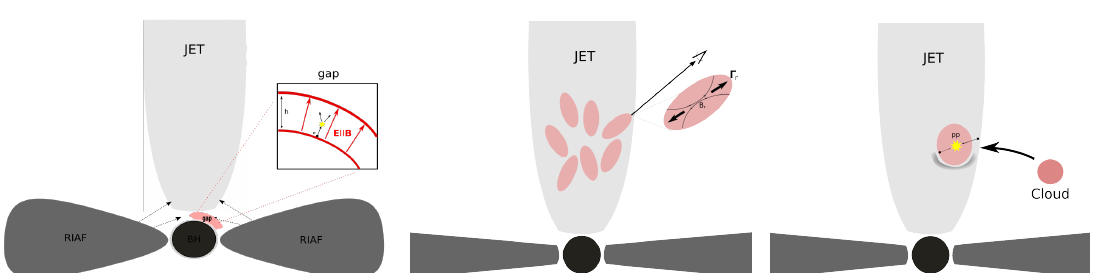
Figure 3. Possible scenarios for the origin of rapidly-variable VHE emission in AGN. Left: Particle acceleration in unscreened (“gap”) electric fields close to the black hole horizon triggers an electron-positron pair cascade, which is accompanied by inverse Compton up-scattering of the ambient disk photon to the VHE regime. VHE variability then becomes a possible signature of jet formation [26]. Middle: Jets-in-jet model [27], where a variety of “mini-jet” features (“plasmoids”) is produced by magnetic reconnection events within the main jet flow. This could lead to an additional velocity component relative to the main flow ( Γ r ) and allow for a favorable orientation (i.e., increased Doppler boosting and time scale reduction) with respect to the observer. Right: Illustration of a hadronic model, where interactions of the jet with a small, massive obstacle (star or cloud) facilitate shock-acceleration and introduce a sufficient target density to allow for efficient pp -collisions